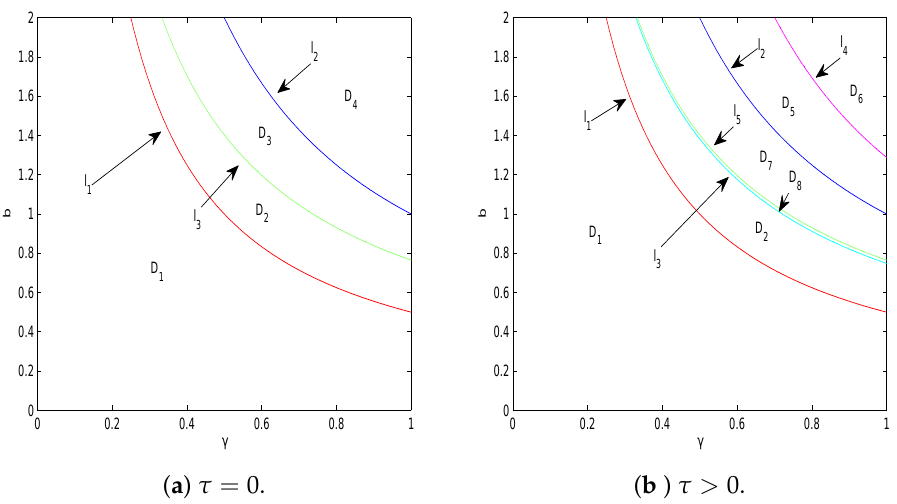
Figure 1. Bifurcation diagram of positive equilibrium in γ –b plane for a = 0.2, ε =